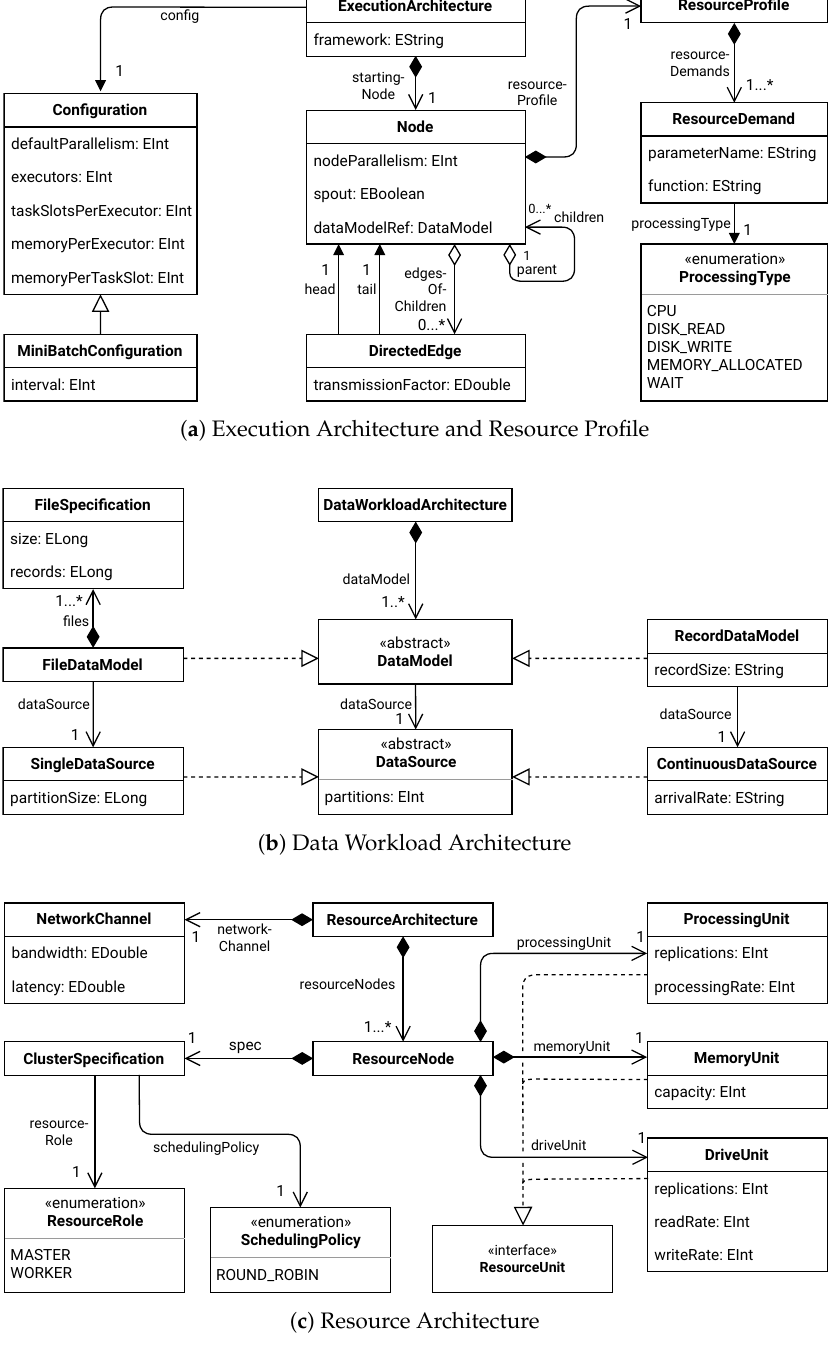
Figure 3. PerTract-DSL classes and